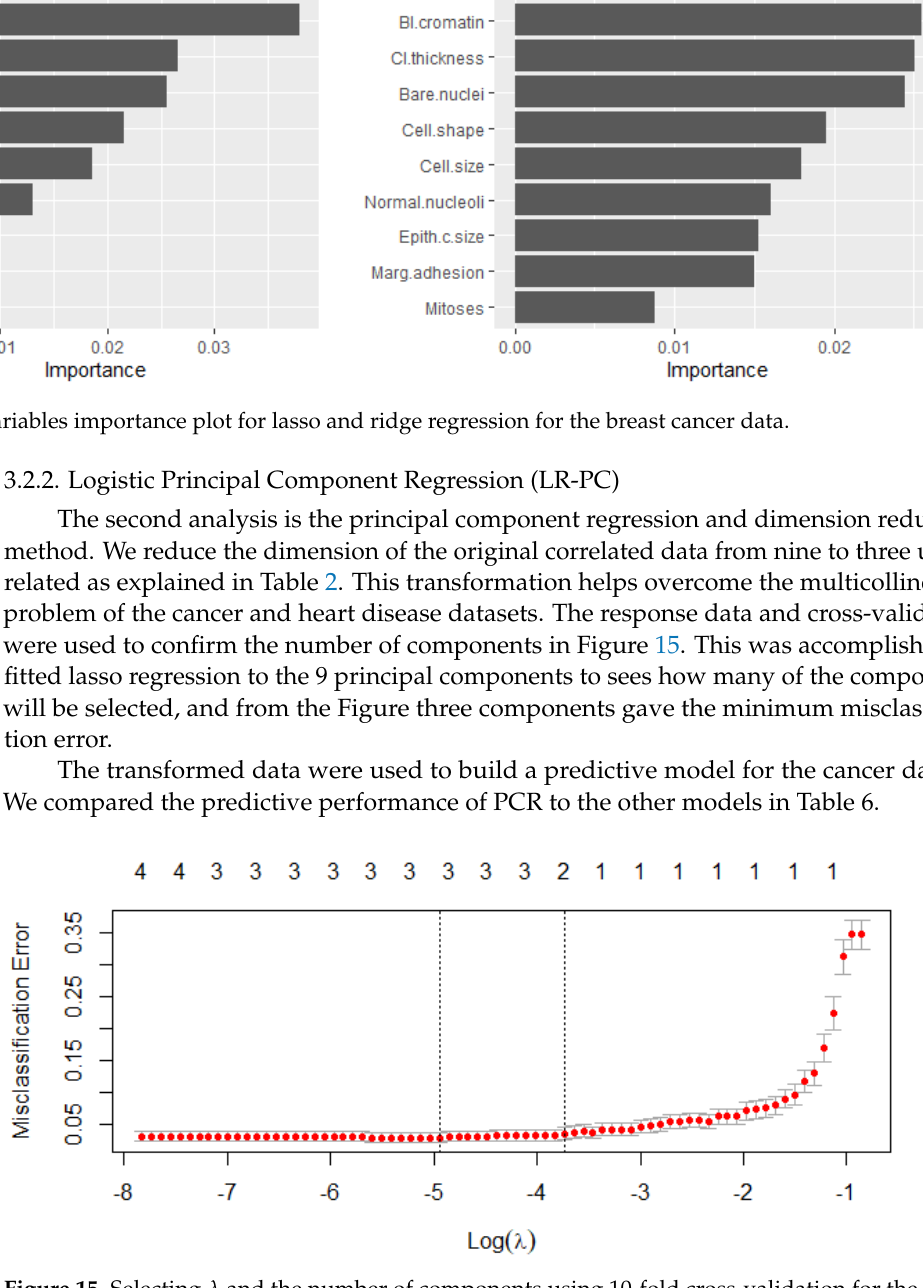
Figure 15. Selecting λ and the number of components using 10-fold cross-validation for the breast cancer